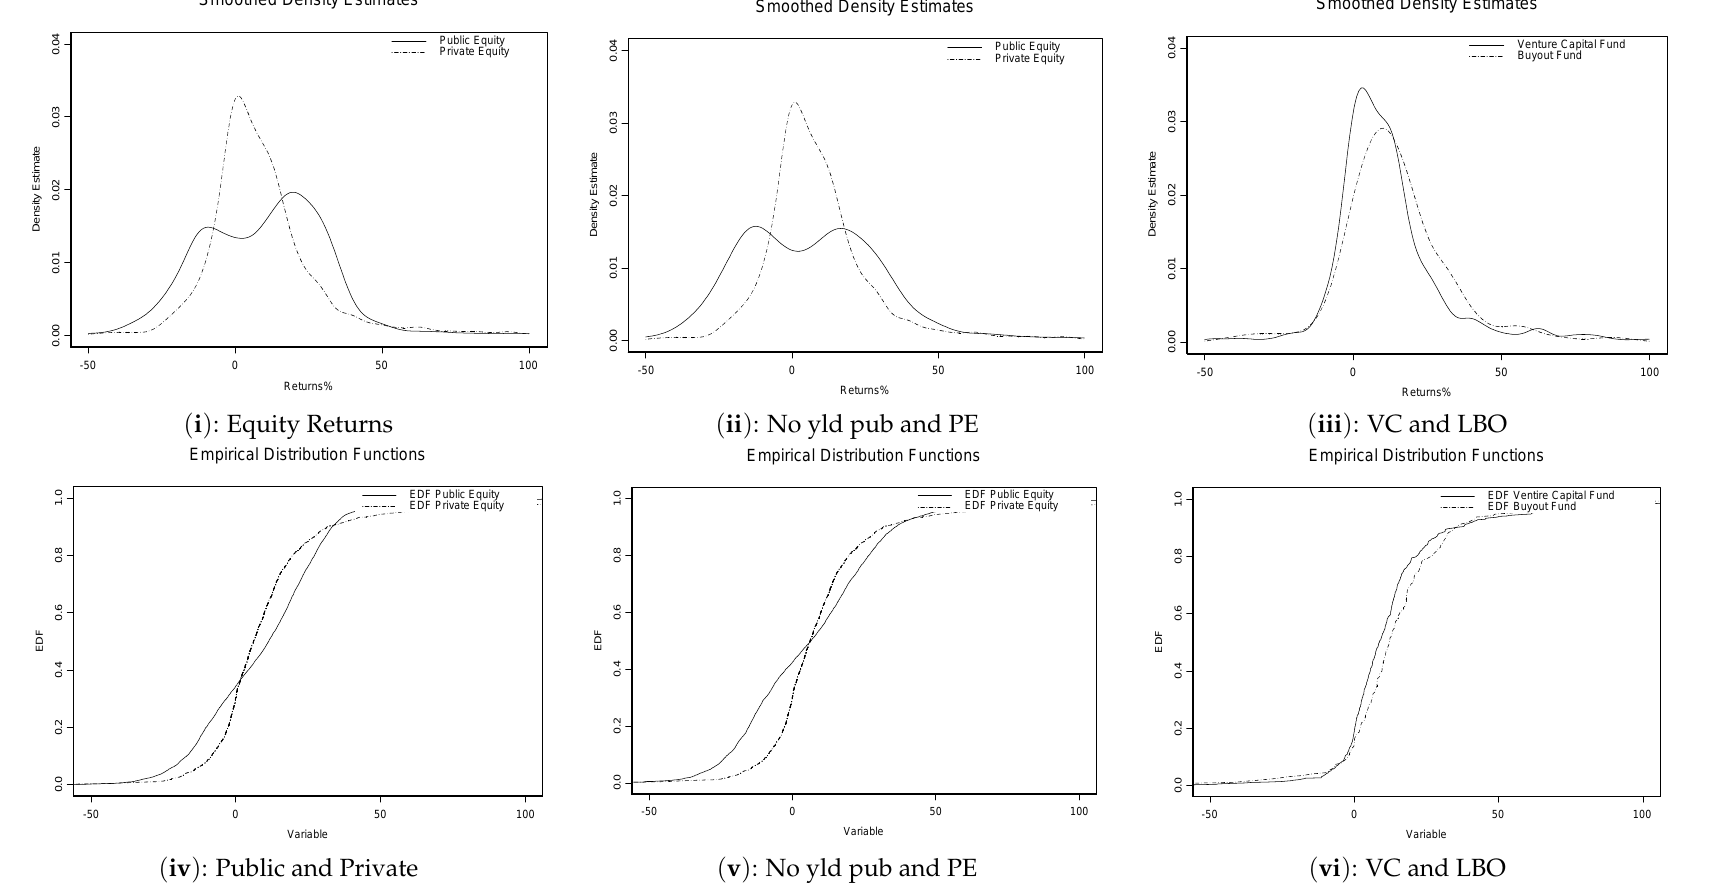
Figure 2 ( iv ) : Public and Private. Figure 2 ( v ) : No yld pub and PE. Figure 2 ( vi ) : VC and LBO. Figure 2. Kernel density functions ( i , ii ) and empirical distribution functions ( iv , v ) of unadjusted annual public equity funds returns (1996–2002) and private equity internal rates of returns (inception before 1996); ( iii , vi ) are the kernel density estimates of venture capital (VC) and buyout funds